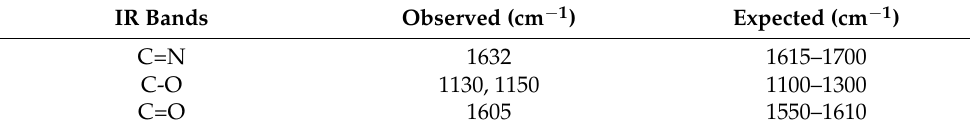
Table 1. The results of IR spectrum analysis.